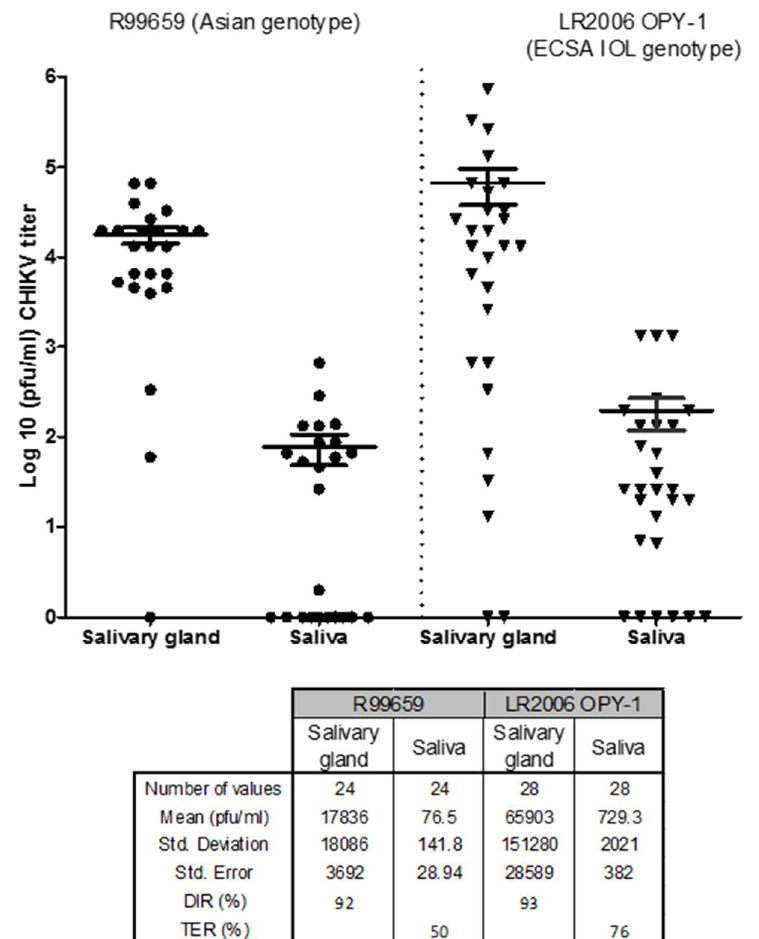
Figure 3. CHIKV titers in Poza Rica A. aegypti strain from Mexico. Ae. aegypti (Poza Rica) were orally infected with either CHIKV R99659 (blood meal virus titer 6 × 10 7 pfu/mL) and CHIKV LR2006 OPY1 (blood meal virus titer 3 × 10 7 pfu/mL). Virus titers were determined 9 days later by plaque assay in salivary glands and saliva. The number of mosquitoes assayed for each CHIKV strain and the prevalence (% infection) of CHIKV in saliva are listed. Horizontal bars show mean titer values with SEM.